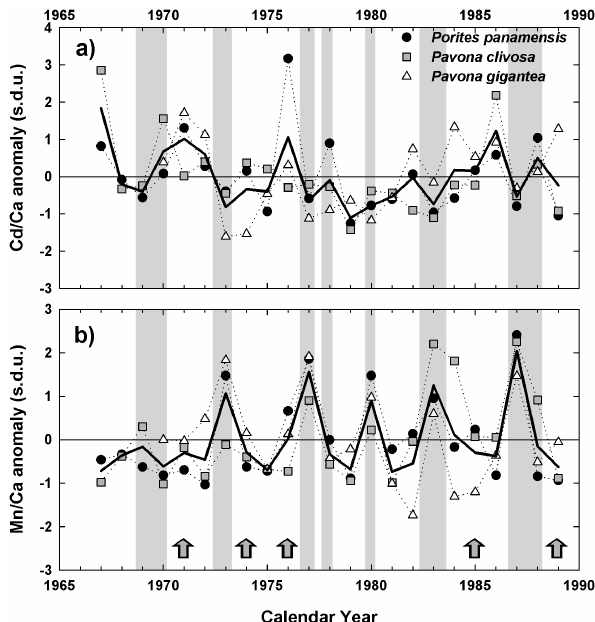
Fig. 5. Temporal variation for the 1967–1990 period of the normal- ized anomalies in standard deviation units (s.d.u.) of the Cd/Ca ratio in three species of corals studied (a) and temporal variation of the normalized anomalies (s.d.u.) of the Mn/Ca ratio (b) . The solid line represents the average anomalies for both trace metal ratios. The gray bars define the timing and duration (months) of the El Ni˜no events and the arrows indicate the cold events of La Ni˜na defined by Trentberth (1997).